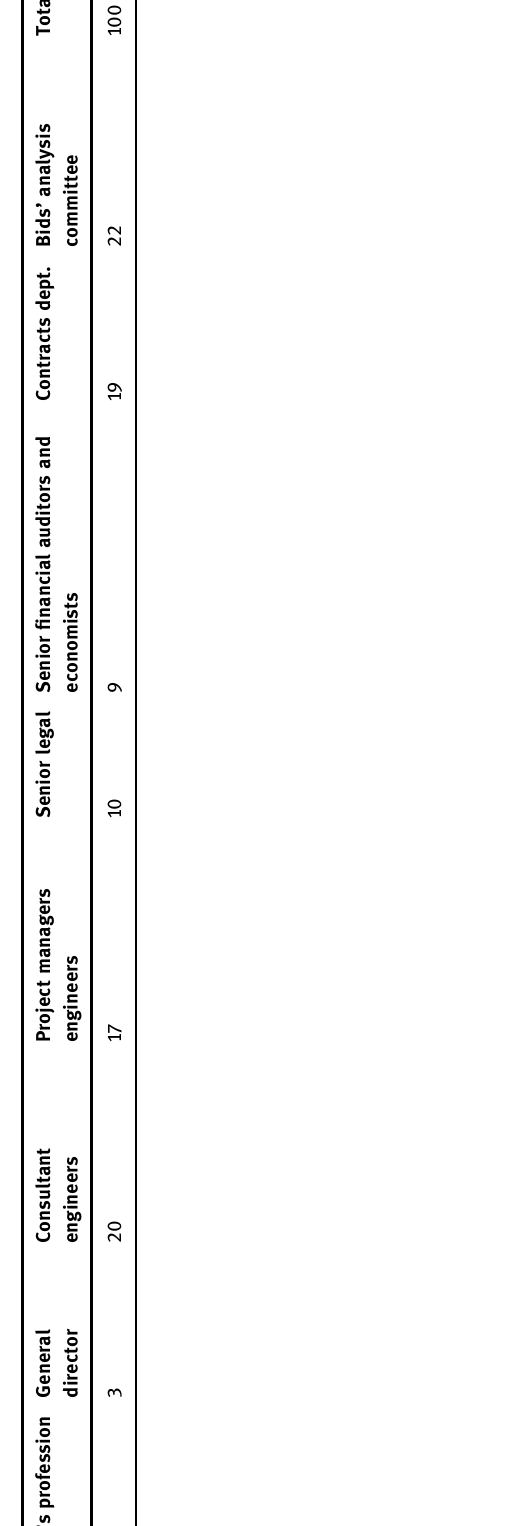
Table 5: Level of reliability and its coe ffi cient for Cronbach ’ s